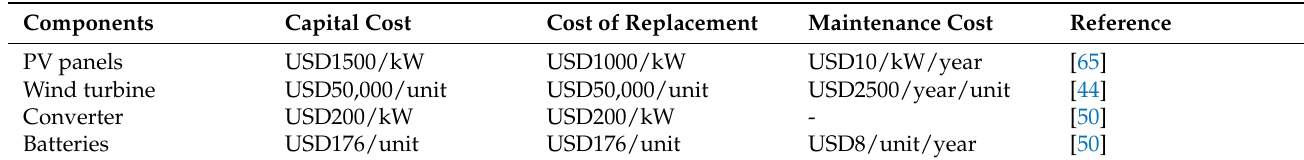
Table 9. Economic data of the hybrid energy system components.